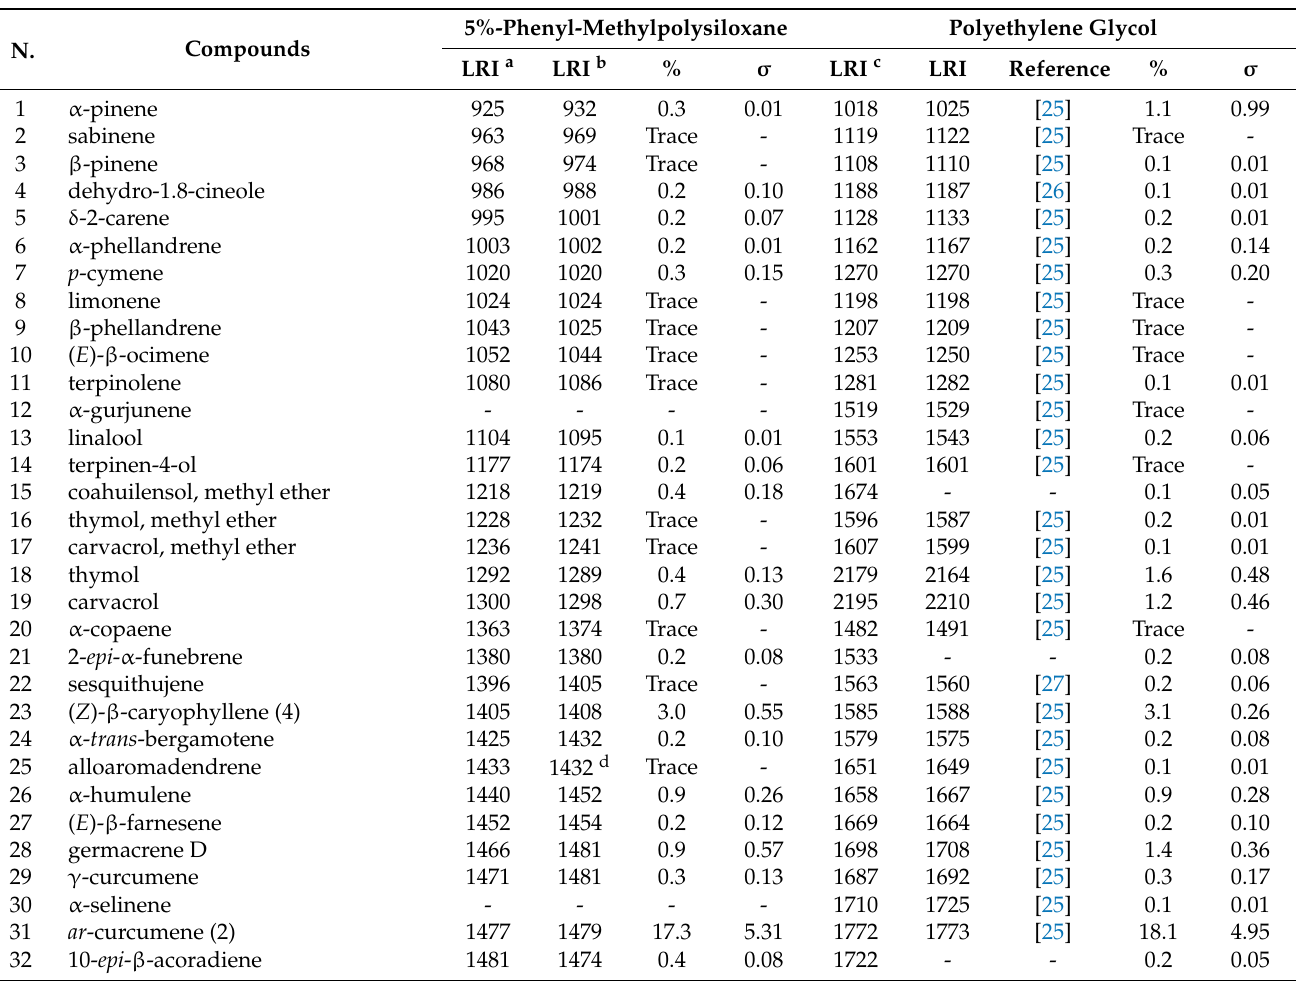
Figure 6. Enantiomeric pairs detected by GC enantioselective analysis: (1 R ,5 R )-(+)- β -pinene ( 7 ), (1 S ,5 S )-( – )- β -pinene ( 8 ), ( R )-( − )- α -phellandrene ( 9 ), ( S )-(+)- α -phellandrene ( 10 ), ( S )-(+) - terpinen-4-ol ( 11 ), and ( R )-( − ) - terpinen-4-ol ( 12 ). Table 2. Enantioselective analysis of K. longipetiolata EO on a 2,3-diethyl-6- tert -butyldimethylsilyl- β -cyclodextrin-based GC column.